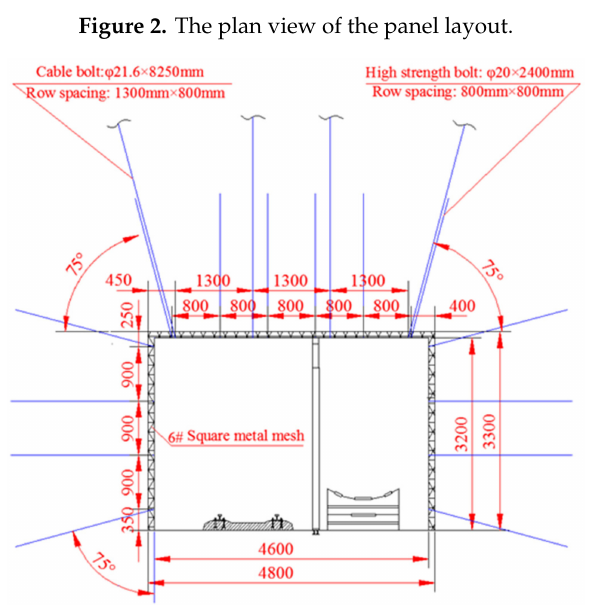
Figure 3. Gateroad support